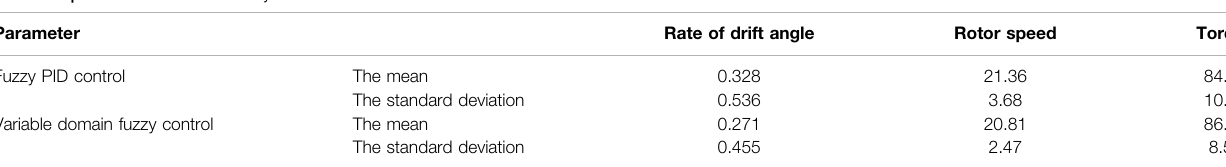
TABLE 4 | Simulation statistics analysis.